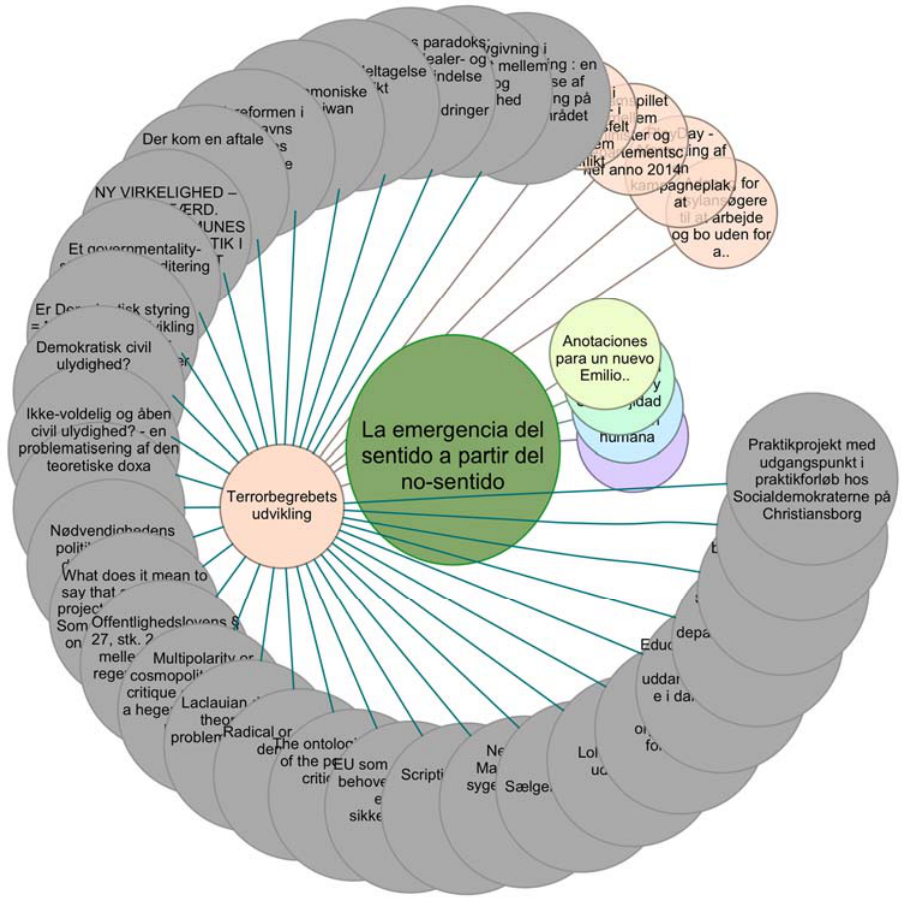
Figure 15. Graph ‐ type visualization of the example results. Figure 15. Graph-type visualization of the example